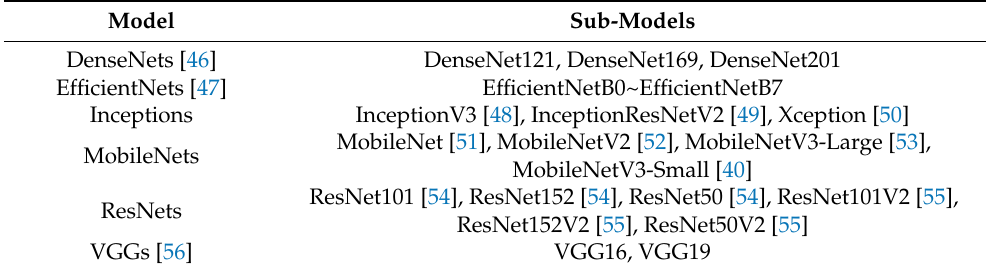
Table 1. Pretrained models used for the transfer